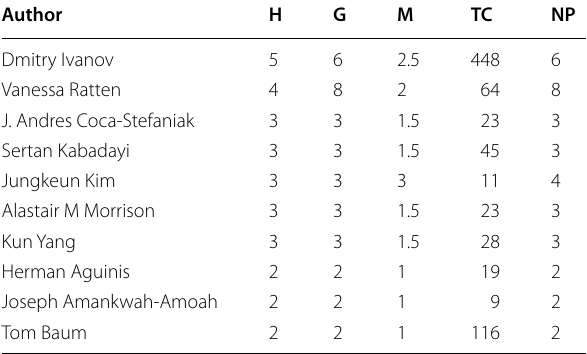
TC, NP, H, G, and M denote total citation, number of publications, H-index, G-index and M-index